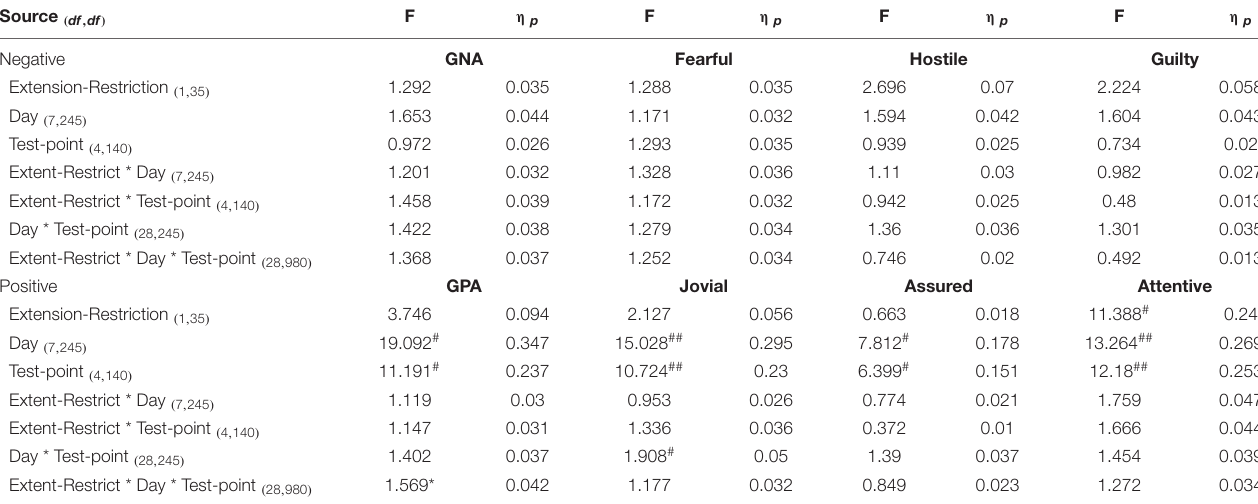
TABLE 2 | Effects of sleep restriction and time of day on Negative and Positive